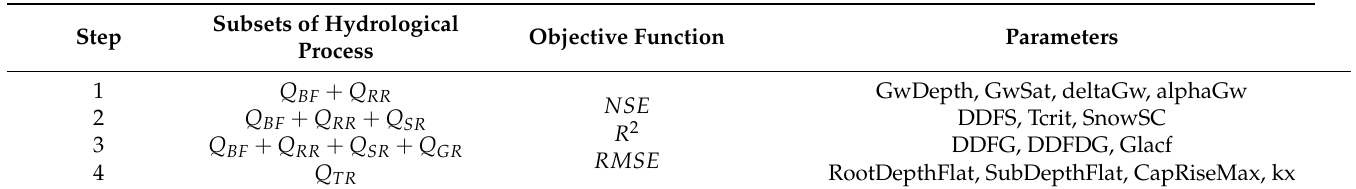
Table 2. Stepwise calibration of SPHY model parameters based on the HPC division